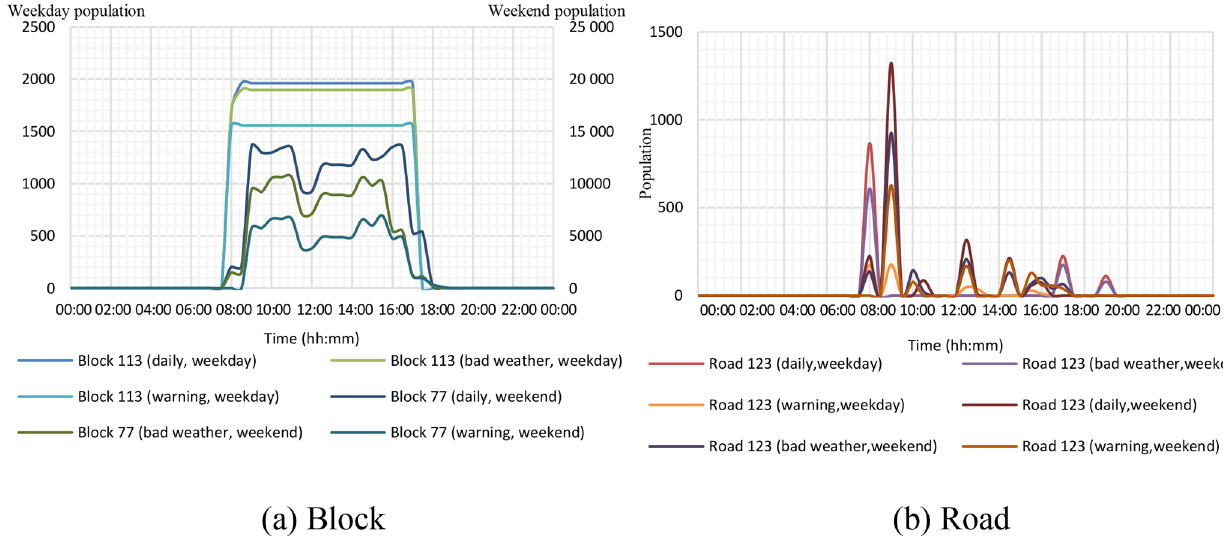
Figure 12. Population changes in blocks and roads for the six scenarios.